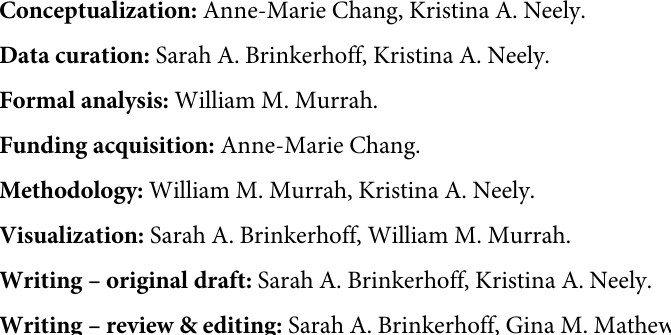
S4 Table. Random slopes models with study design and KSS. Note. Values given in Estimate (Standard Error); VG = Visually Guided; MG = Memory-Guided; KSS = Karolinska Sleepiness Scale. Fourth series of models, comparing random slopes for day and vision and no random slopes. The best-fitting model of the series—determined by AIC—was Model 4: